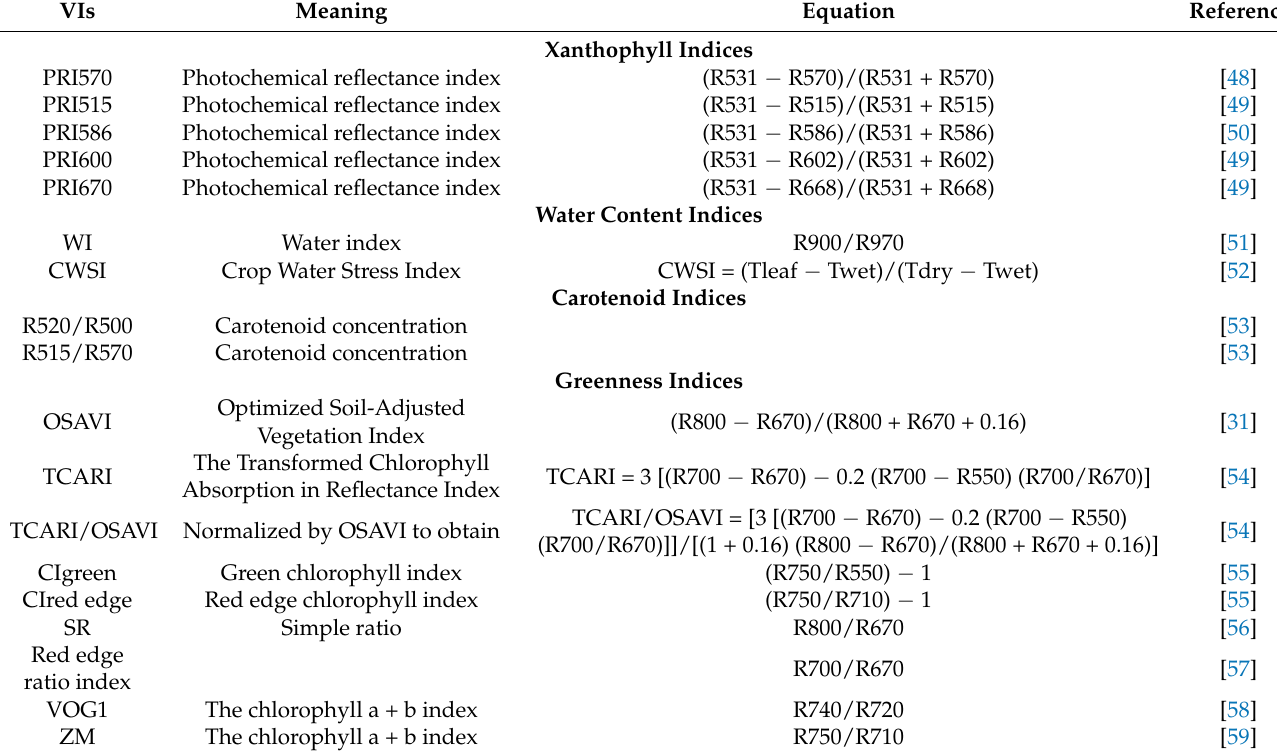
Table 2. Classification, explanation, and equations of different vegetation indices (VIs) included in this